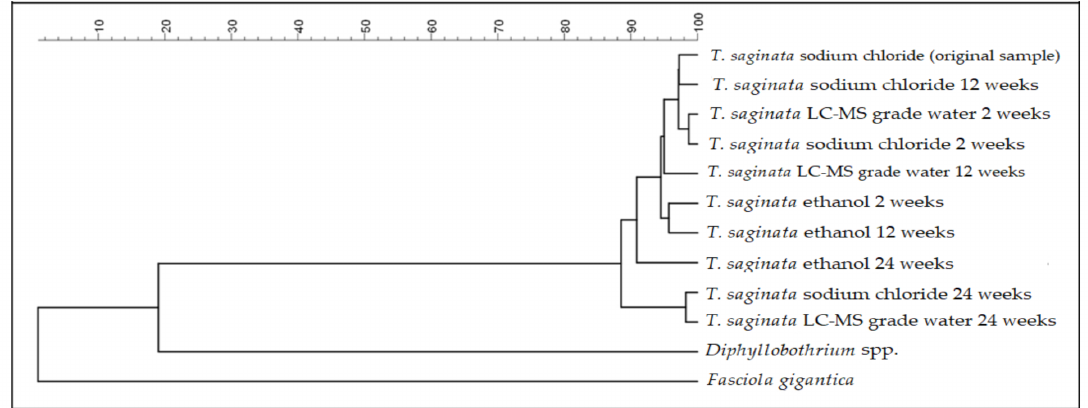
Figure 3. Dendrogram derived from a clustering analysis to assess and compare the different protein spectra of Taenia saginata proglottids stored in three storage media for different time periods. The cestode Diphyllobothrium spp. and the trematode Fasciola gigantica were added as outgroup